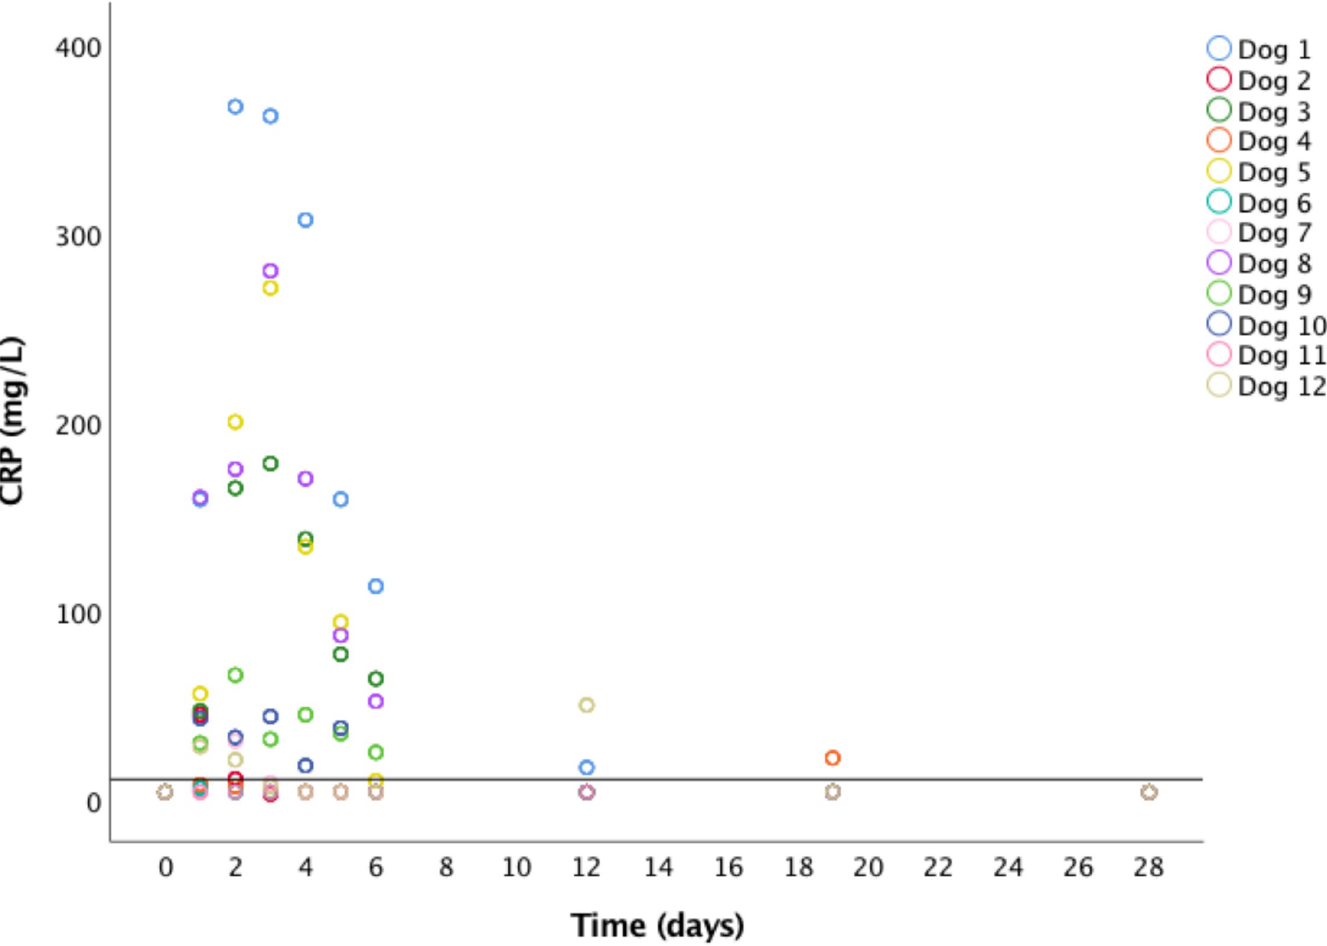
Fig 3. Scatter plot depicting individual C-reactive protein (CRP) values in serum measured from dogs at each post-interventional control at days 1 to 6, 12, 19, and 28. The continuous horizontal red line shows the reference value for CRP ( < 10.7 mg/L). No elevations were noticed 4 weeks after intraprostatic steam application.